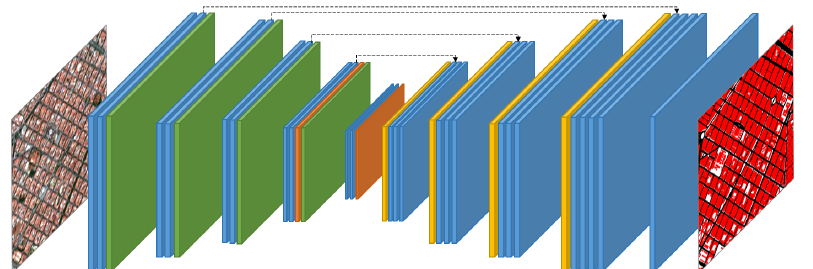
Figure 1. U-net architecture [40] adapted to a multi-class semantic segmentation problem, including building footprints and road networks. Note that the final 1 × 1 convolutional layer performs a classification into 3 classes since the background is also